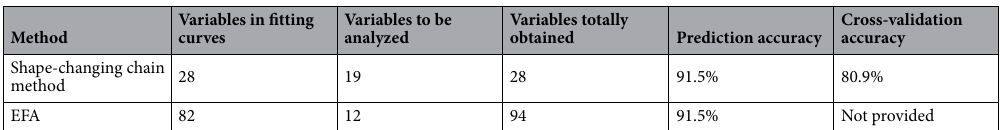
Table 3. Numbers of variables used in the shape-changing chain method and in EFA 17 for fitting and analyzing human mandible